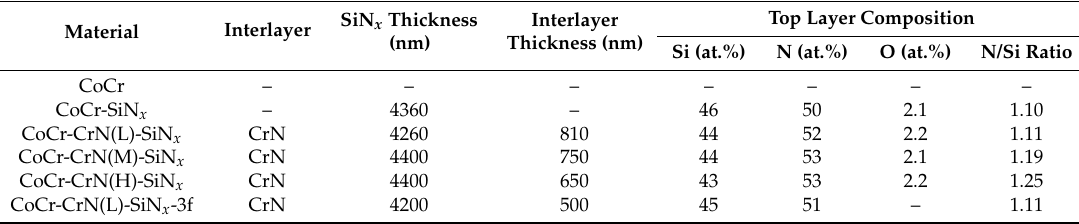
Table 1. The investigated materials, coating thicknesses, and chemical composition of the SiN x top layers as measured by XPS.